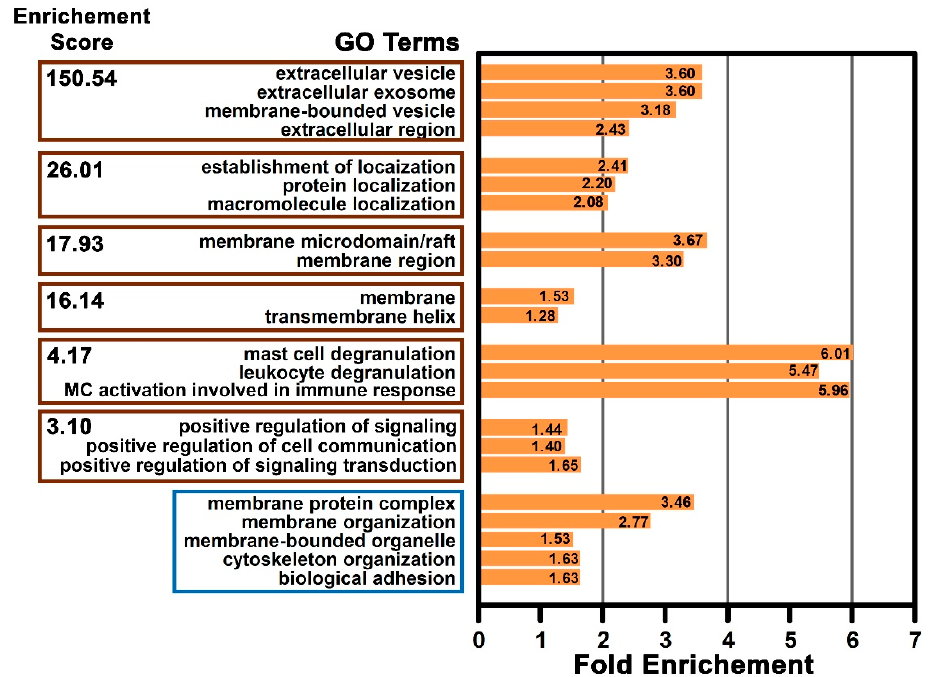
Figure 7. Functional relationship among the proteins and their associated GO terms in the mast cell lipid raft proteome. Groups with the highest enrichment scores following analysis using DAVID are shown. The enrichment score groups (brown rectangles) and non-grouped terms (blue rectangle) are indicated according to their biological significance. The fold enrichment factor (orange bars) is also shown. Data was analyzed using the DAVID Bioinformatics Resources database.